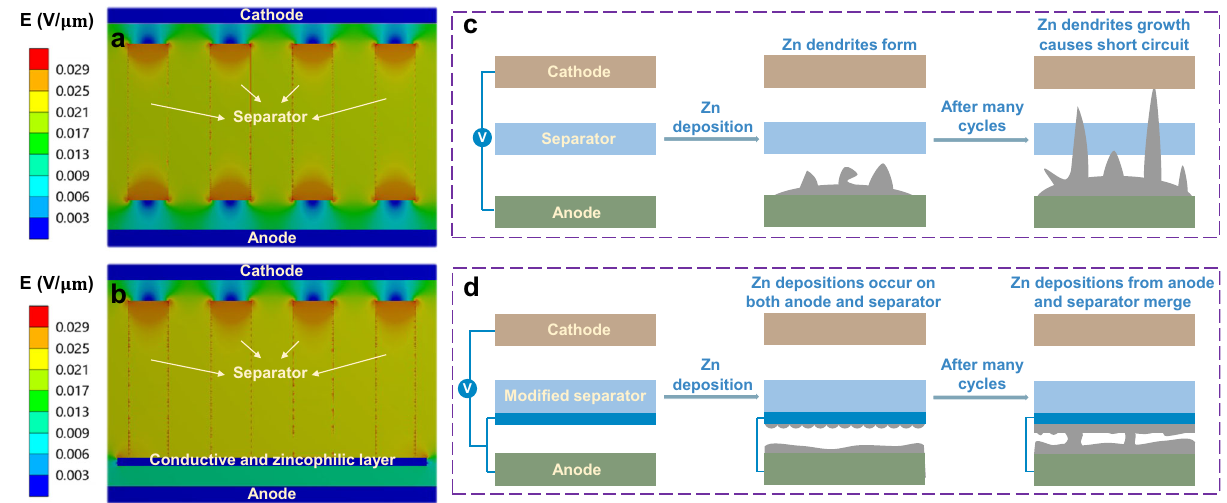
Fig. 1 Theoretical calculation and protection mechanism of modi fi ed separator. a Electric fi eld distribution with the pristine separator. b Electric fi eld distribution in the non-contact region of the modi fi ed separator and the anode. c Schematic illustration of Zn deposition with the pristine separator. d Schematic illustration of Zn deposition in the contact region of the modi fi ed separator and the anode (see Supplementary Note 1 for